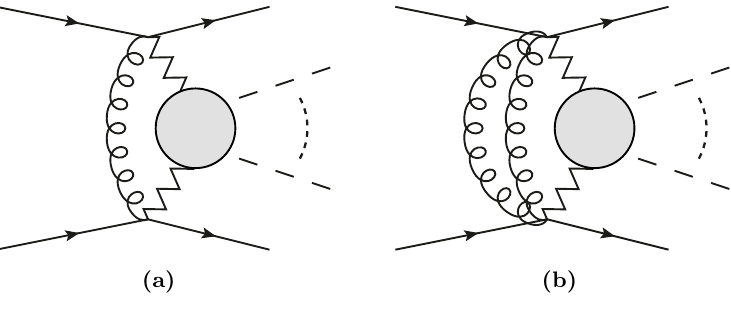
Figure 7. Non-factorisable 1-loop (a) and 2-loop (b) corrections in the eikonal approximation. Notice that these are two-dimensional euclidean diagrams in the plane transverse to the incoming quark